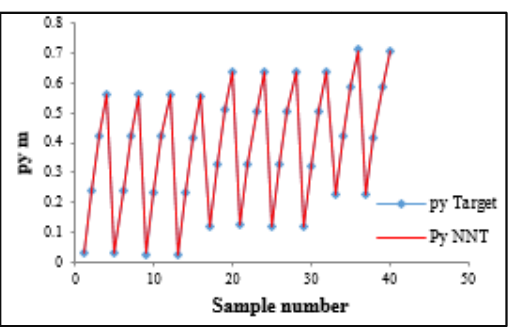
Fig. 18. the comparison between py target and py